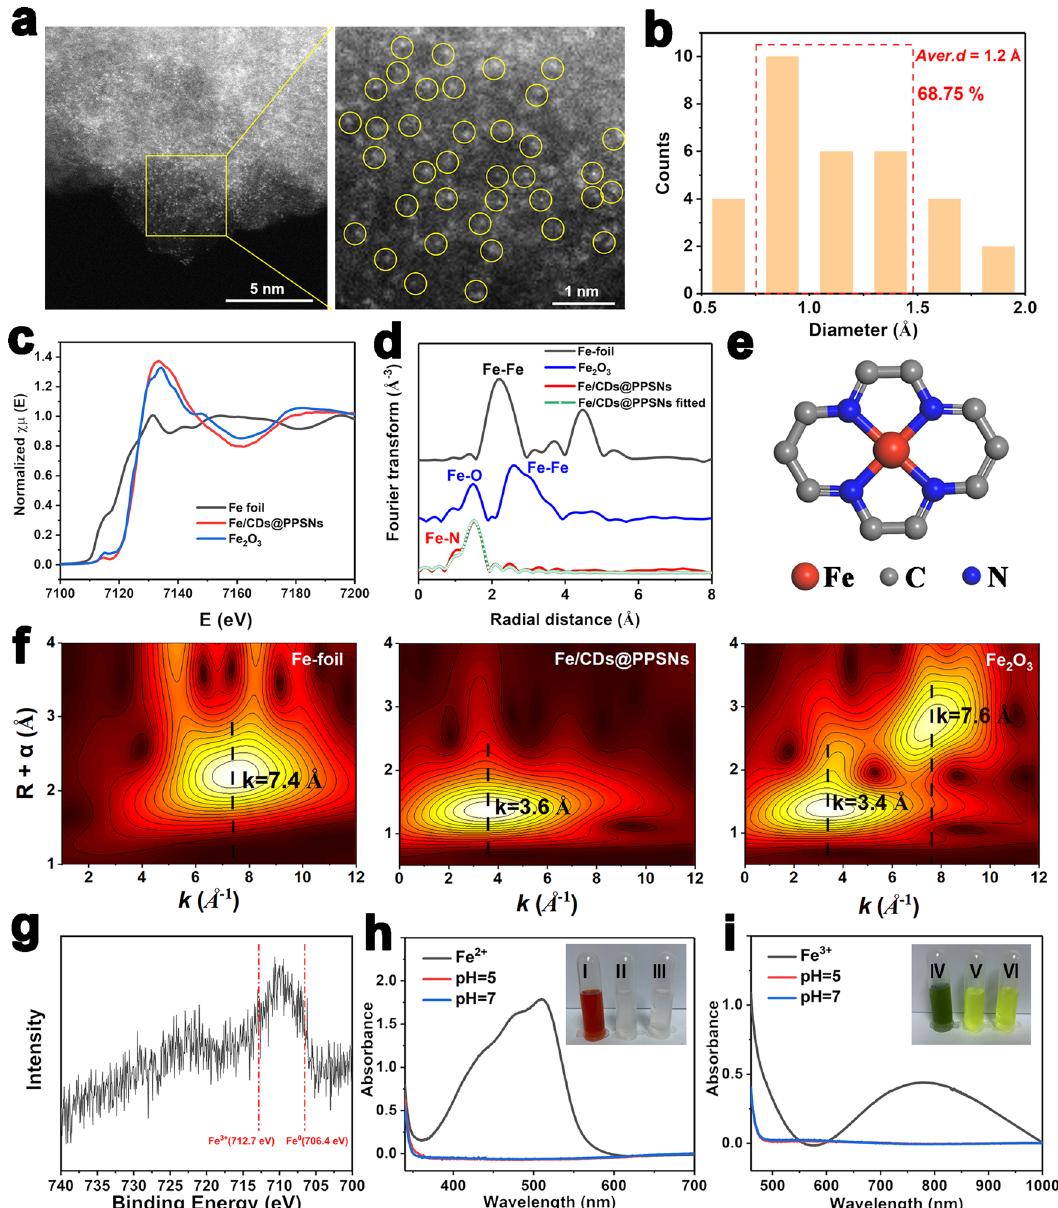
Fig. 3 Characterizations of Fe state in Fe/CDs@PPSNs. a Aberration-corrected HADDF-STEM images of Fe/CDs@PPSNs after the etching by NaOH. The bright dots indicate the highly dispersive Fe single atoms in the carbon matrix. b Histogram diameter distribution of iron species. Data were collected using Digital Micrograph software. c Fe K-edge XANES spectra of Fe foil, Fe 2 O 3 , and Fe/CDs@PPSNs. d Fourier transformation EXAFS spectra of Fe foil, Fe 2 O 3 , and Fe/CDs@PPSNs in R-space. e The proposed Fe-N 4 -C local environment. f Wavelet transformation EXAFS spectra of Fe foil, Fe 2 O 3 , and Fe/ CDs@PPSNs. g Fe2 p XPS spectrum of Fe/CDs@PPSNs. Detection of ferrous and ferric ions by o-phenanthroline h and K 3 Fe (CN) 6 i agents at different pH values. Insets in h and i : (I-III) Digital photos of ferrous ions with o-phenanthroline and treating Fe/CDs@PPSNs with o-phenanthroline at pH = 5 and pH = 7, respectively; (IV-VI) Digital photos of ferric ions with K 3 Fe (CN) 6 and treating Fe/CDs@PPSNs with K 3 Fe (CN) 6 at pH = 5 and at pH = 7,